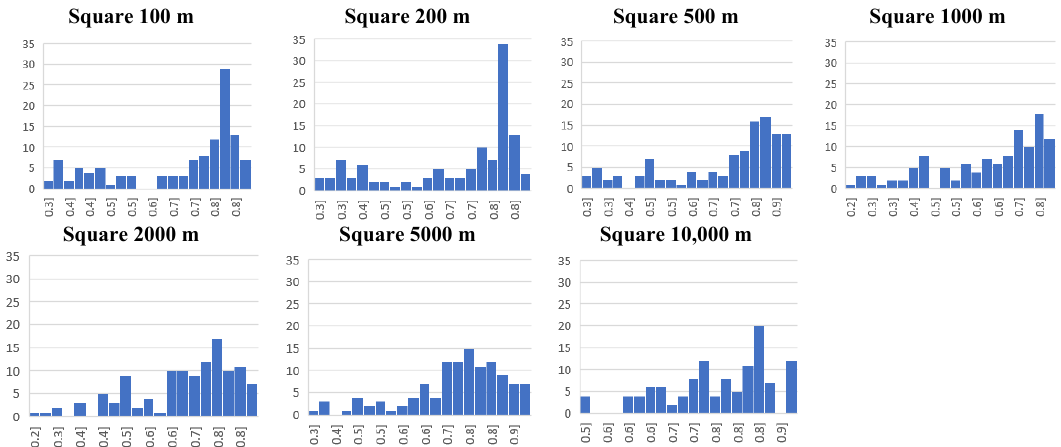
Figure 9. Histogram of the distribution of indices of passability for the analysed cell sizes for the 1000 m control point grid (2942 points).